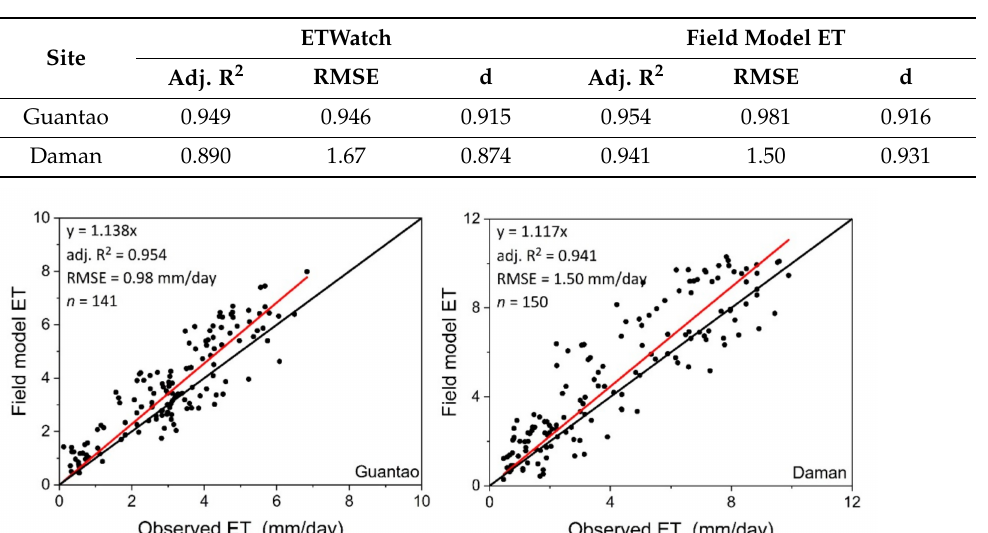
Table 1. Site evaluation of the field model evapotranspiration (ET) allocated from the ETWatch data.